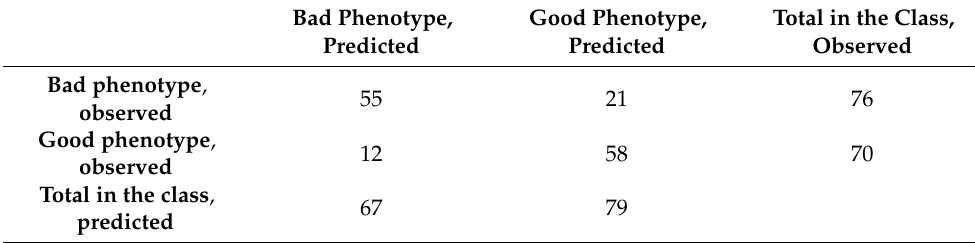
Table 2. Confusion matrix for the minimal classification model based on colony parameters, showing the numbers of correctly and incorrectly classified colonies in the groups of the good and bad phenotypes. The first column shows (top) the number of correctly classified colonies with the bad phenotype, (middle) the number of good colonies misclassified as bad, and (bottom) the total number of colonies classified by the model as having the bad phenotype. The second column shows (top) the number of bad colonies misclassified as good, (middle) the number of correctly classified colonies with the good phenotype, and (bottom) the total number of colonies classified by the model as having the good phenotype. The third column shows the total number of (top) bad and (bottom) good